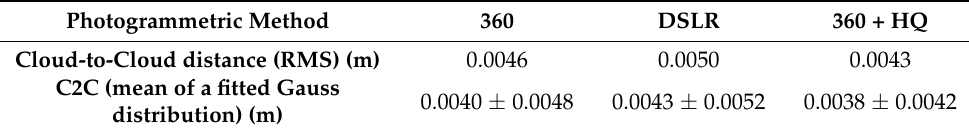
Table 5. Cloud-to-Cloud (C2C) distance measured between the point clouds and a reference laser